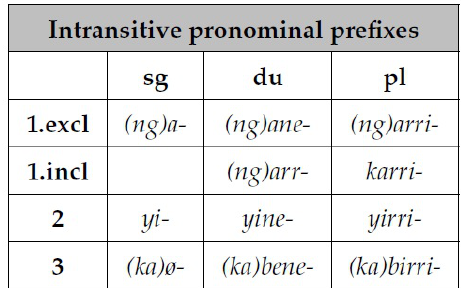
Table 9. Young people’s prefixes in Mamardawerre